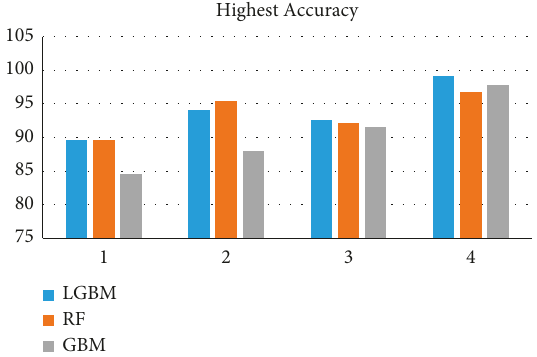
Figure 14: Highest accuracy